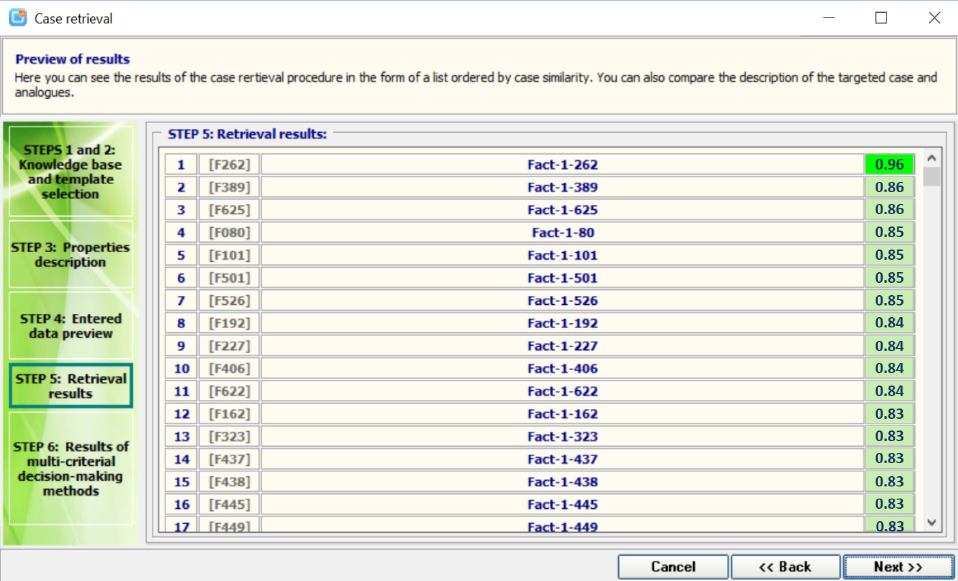
Figure 8. An example of a PKBD GUI form: case retrieval results.